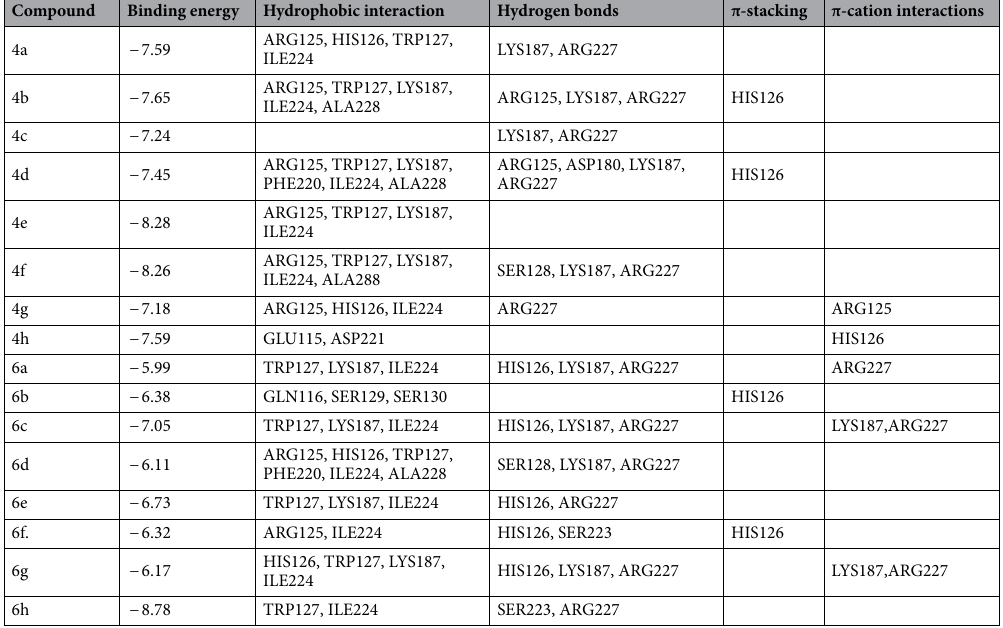
Table 7. The binding affinity of compounds 4a–h and 6a–h with Staphylococcus aureus biotin protein ligase (PDB: 3V7R).